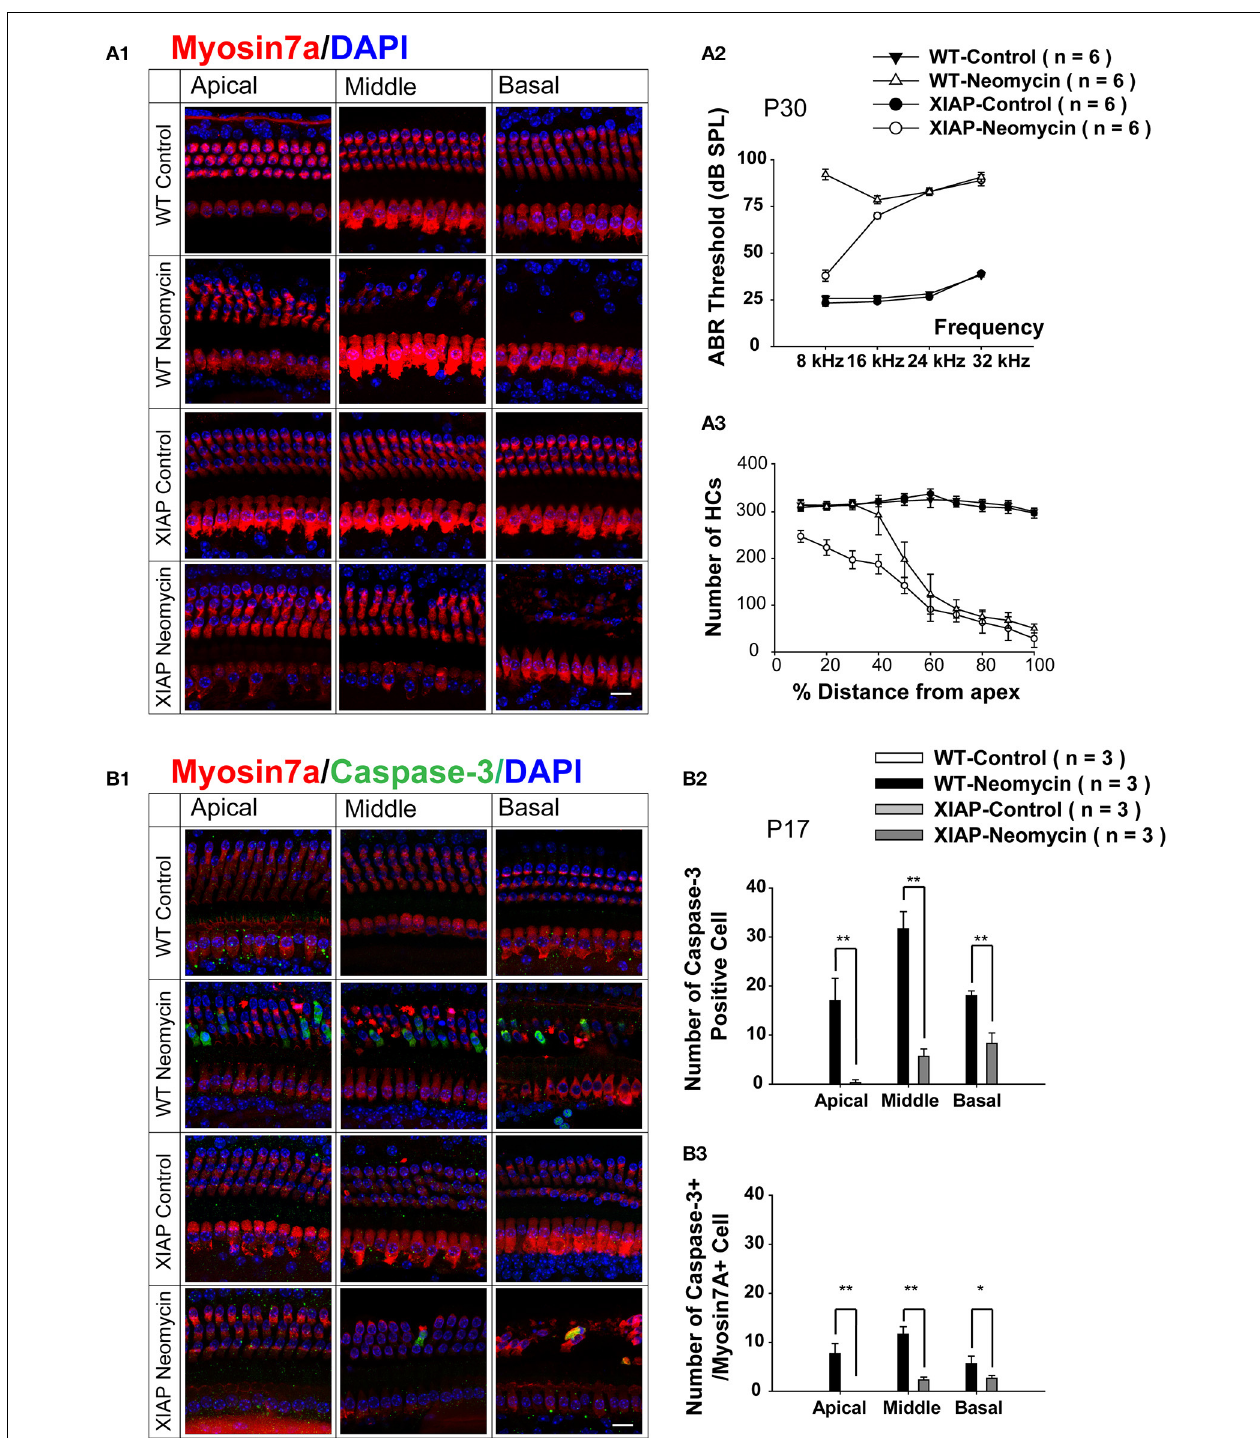
FIGURE 5 | Hearing loss and HC loss in neomycin-treated XIAP overexpression mice. (A1) Representative confocal images of myo7a immunofluorescence in cochlear whole mounts of XIAP overexpression and WT mice treated with neomycin or saline (control) between P8 and P14 (Group 2) and sacrificed at P30. ABR measurement (A2) and myo7a + HC quantification (A3) of P30 XIAP overexpression and WT mice treated with neomycinorsaline(control)betweenP8andP14. (B1) Representativeconfocal